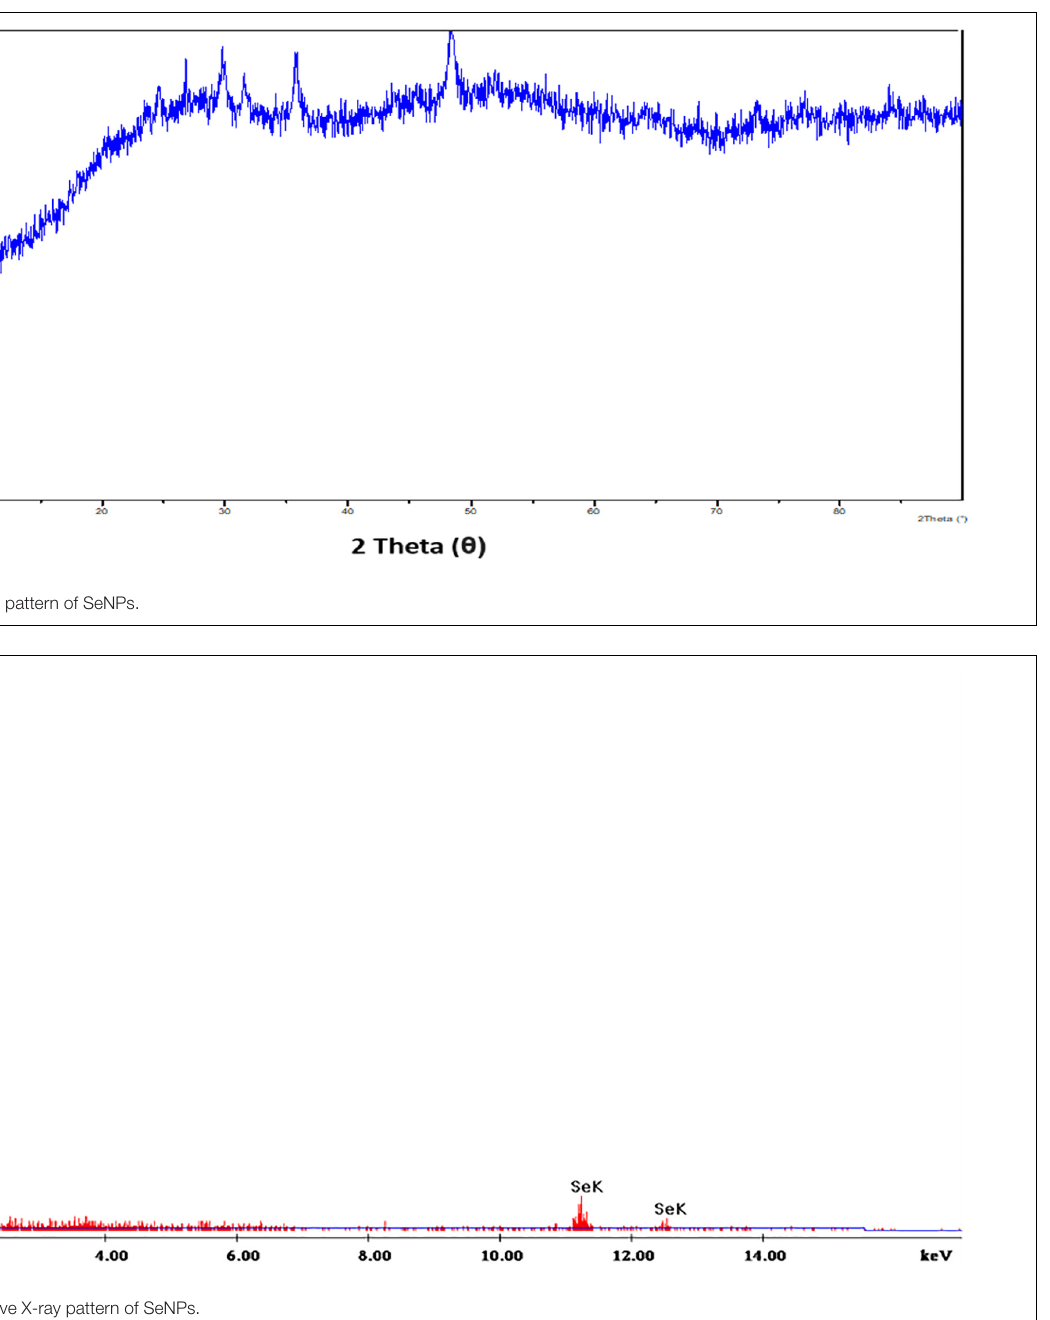
FIGURE 6 | Energy-dispersive X-ray pattern of